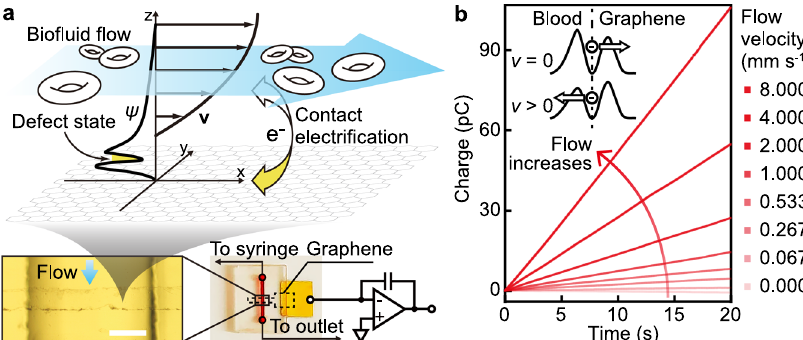
Fig. 1 Transducing blood- fl ow velocity to electric current by using a graphene single-microelectrode device. a Coulometric measurement of contact- electri fi cation charge transfer between whole-blood fl ow and graphene. Graphene is shown by the gray honeycomb lattice. The whole blood contains multifarious components such as red cells which are depicted in the schematic. The direction of the whole-blood fl ow is represented by the blue arrow. The thick curves represent the pro fi les for the fl ow velocity ( v ) and the electrical potential ( ψ ) along the z -axis normal to the graphene – water interface ( x – y plane). The fl ow velocity fi eld is shown by the thin black arrows enveloped by the velocity pro fi le. The charge transfer indicated by the white-yellow arrow is through the graphene-defect state highlighted on the ψ pro fi le. The optical microscope image shows a monolayer-graphene microelectrode crossing over the micro fl uidic channel in an acrylic chip. The scale bar is 200 μ m. The graphene microelectrode is connected to the gold contact that is wired to an electrometer based on an operational ampli fi er with a feedback capacitor. b The measured unsmoothed charge transfer of a graphene device as a function of time for different blood- fl ow velocities. The diagram illustrates the electrical potential variation at a graphene-defect site and the corresponding variation in the electron transfer through the defect state, when the blood- fl ow velocity magnitude ( v ) changes. The vertical dash line indicates the graphene-defect state at the graphene/blood interface. The arrows represent the directions of the net electron fl